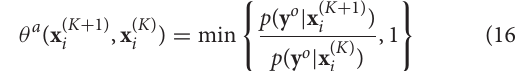
algorithm. To satisfy the modified local balance